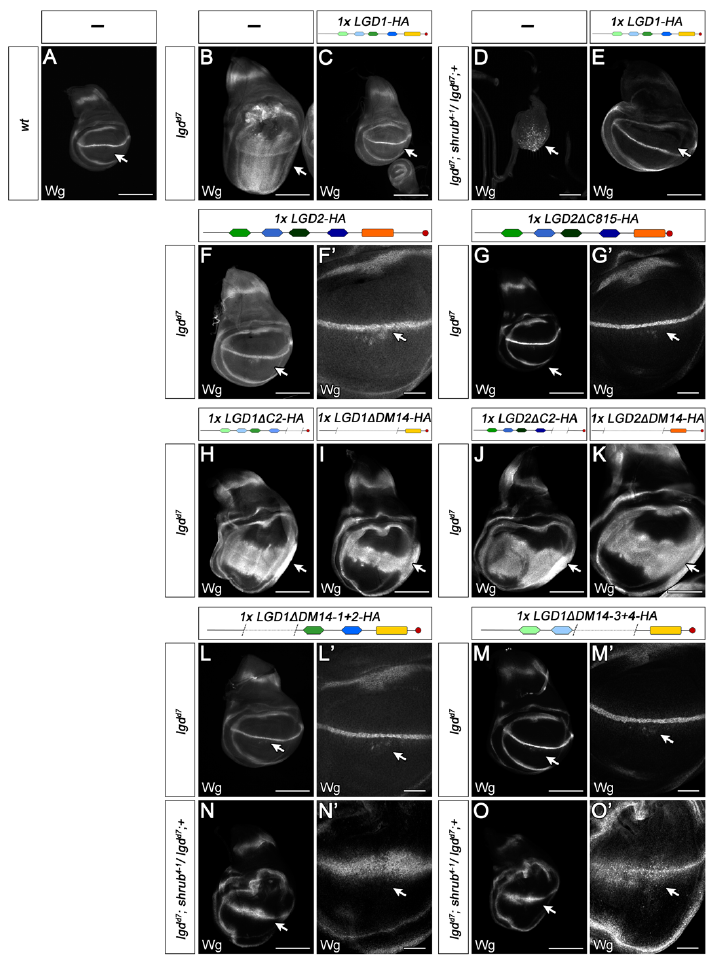
Figure 3. Structure/function analysis of the human LGDs in Drosophila . In each panel, the indicated lgdP ‐ LGD1/2 variants were expressed in the lgd null ( lgd d7 ) or sensitised background ( lgd d7 ; shrub 4 − 1 /lgd d7 , + ) to assess their rescue activities. The wing imaginal discs were stained for the Notch target gene, wingless ( wg ) to reveal the activity of the Notch pathway (arrow). ( A ) During normal development Notch ‐ dependent wingless expression is restricted to a stripe straddling the dorsal/ventral (D/V) compartment boundary. ( B ) The loss of lgd function causes the expansion of the expression of Wg, revealing the ectopic activation of Notch in the wing anlage. In addition, the ectopic activation of the Notch pathway also causes massive over ‐ proliferation, leading to the increase in the size of the disc. ( D ) The phenotype of lgd mutant discs worsened dramatically upon loss of one copy of shrub ( lgd d7 ; shrub 4 − 1 /lgd d7 , + ). The animals of this sensitised background die during the early third instar larval stage. They have very small discs with Wg primarily located in enlarged endosomes. The presence of one copy of lgdP ‐ LGD1 ‐ HA in lgd mutants or the sensitised background normalises the expression of Wg and disc size indicating the rescue ( C + E ). ( F , F’ ) In contrast to LGD1, LGD2 only partially rescues the lgd mutant phenotype, indicated by the weak ectopic expression of Wg highlighted by the arrow in ( F’ ). No difference in the rescue abilities between full ‐ length LGD2 and LGD2 Δ 815 have been observed (compare with G , G ’). ( H – K ) The C2 ‐ and DM14 ‐ domains are required for the function of LGD1 ( H , I ) and LGD2 ( J , K ), indicated by the failure of rescue of the lgd mutant phenotype by the corresponding variants (compare with B). ( L – M’ ) Variants of LGD1 with only one even ‐ and odd ‐ numbered DM14 domain (LGD1 Δ DM14 ‐ 1+2 and LGD1 Δ DM14 ‐ 3+4) can partially rescue. Only a few cells close to the D/V boundary express Wg ectopically (L’, M’, arrow). ( N – O’ ) The ectopic expression is enhanced in the sensitised background. Scale bars ( A – O ) 200 µ m, ( L’ – O’ ) 50 µ m. At least ten wing imaginal discs were analysed for each